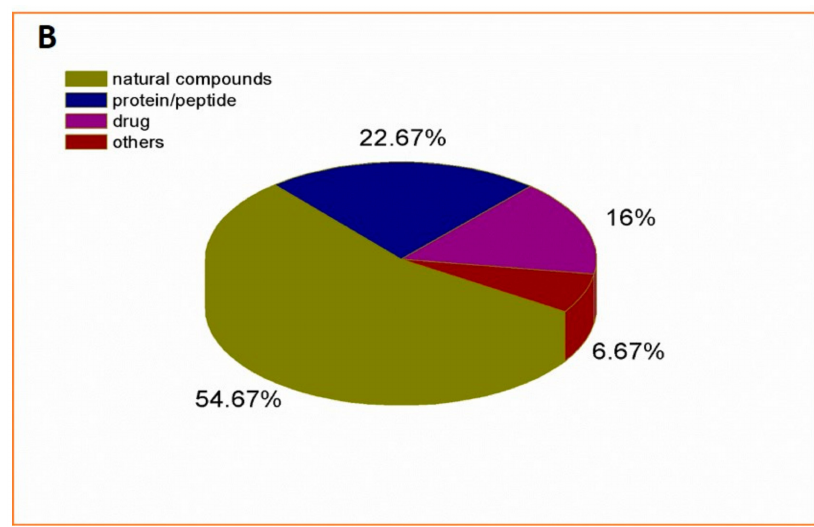
Figure 1. Number of publications searched containing “antimicrobial chitosan conjugate” keywords via ISI Web of Science ( A ); Classification and proportion of corresponding chitosan conjugates ( B ); Note: The data for 2019 are as of the end of